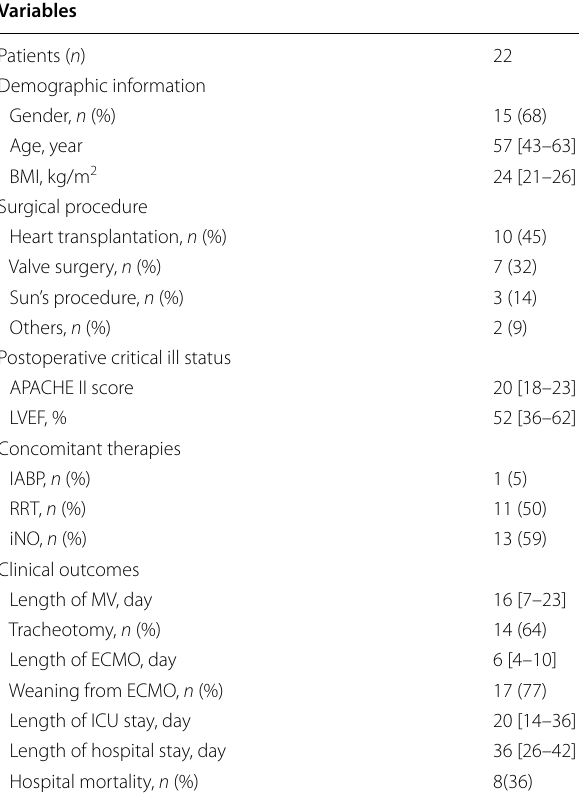
Table 1 Characteristics and clinical outcomes of included